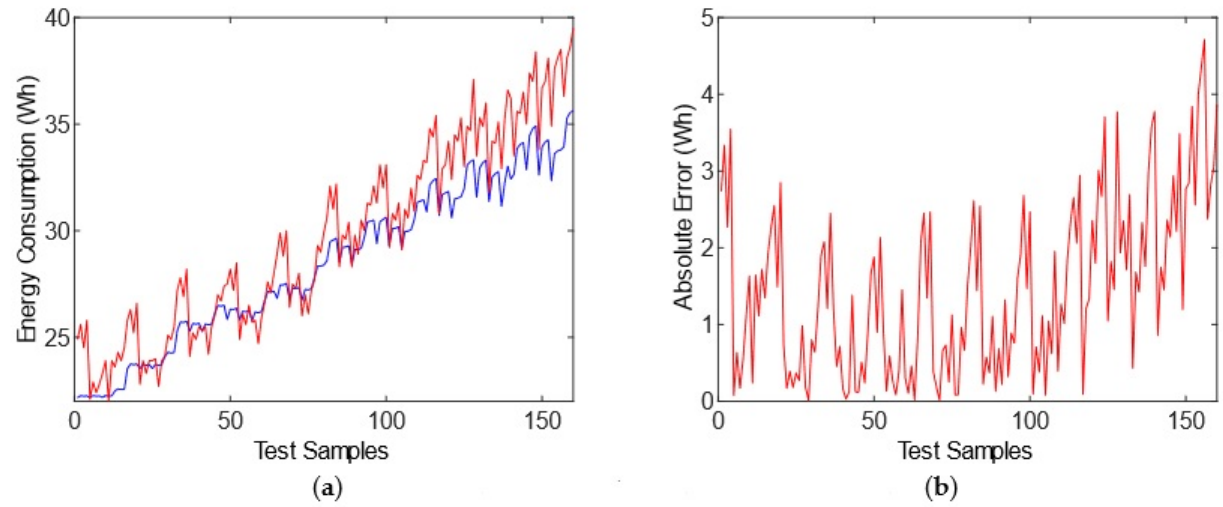
Figure 6. GP model results in Test 2. ( a ) Data estimated (red) versus energy consumption data measured (blue). ( b ) Absolute error between estimated behavior and measured energy consumption (red).